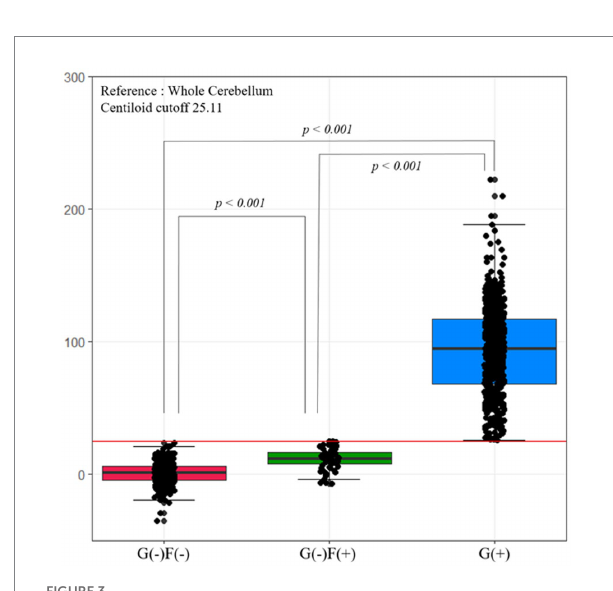
FIGURE 3 Centiloid values according to group. The Centiloid value of the G( − ) F( − ) and G( − )F(+) groups are lower than the cutoff values. Each group has an order of Centiliod value, which tends to increase from group G( − )F( − ) to G(+). F, focal-type amyloid accumulation; G, global standardized uptake value ratio; W, whole region type amyloid accumulation.